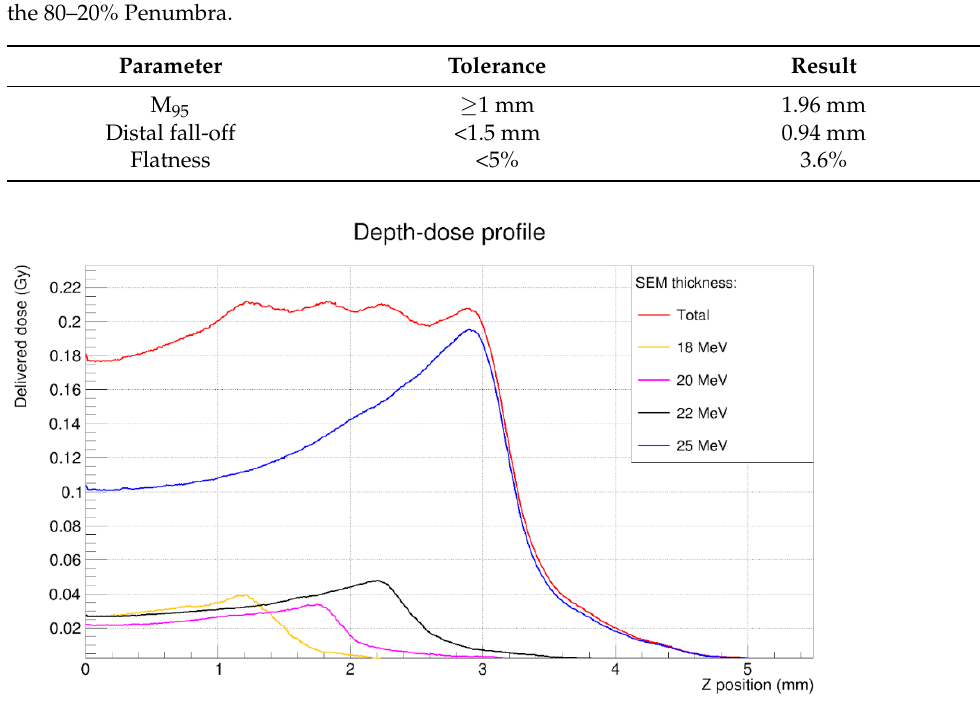
Figure 5. Depth-dose profile obtained at the irradiation point with the contribution of the four selected energies: 18 (yellow line), 20 (magenta line), 22 (black line), and 25 (blue line) MeV; while the red line corresponds to the combination of all them. Table 4. Beam quality parameter tolerances and obtained results of the final depth-dose profile. The calculation of quality parameters is defined in detail in [31]. Here, the distal fall-off was defined as the 80–20% Penumbra.